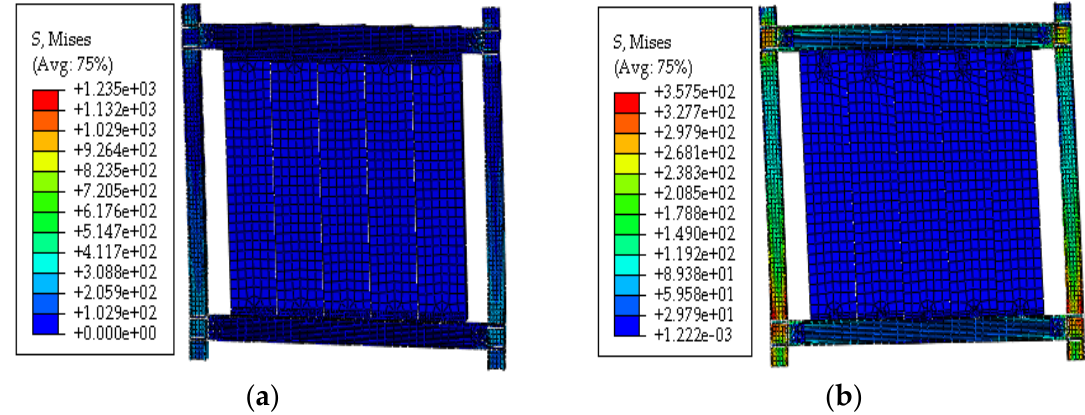
Figure 21. Stress cloud diagram of the test models: ( a ) FW-1; ( b ) FW-2.